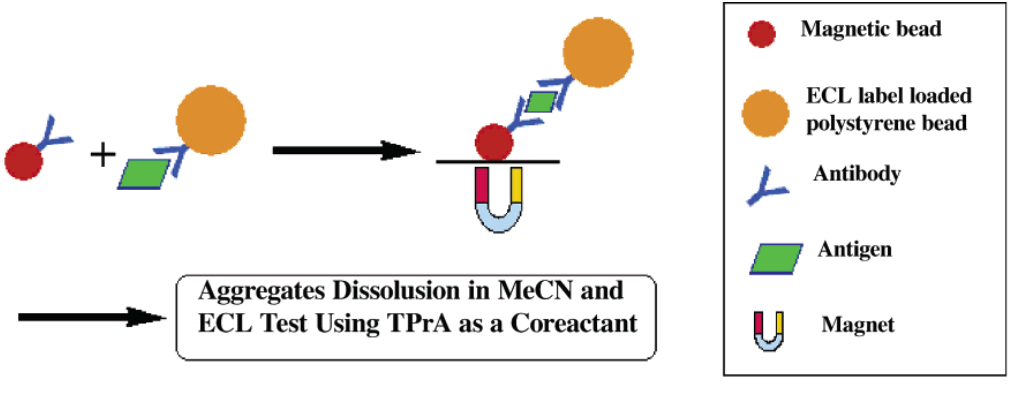
Figure 4. Schematic diagram showing the formation of a sandwich-type aggregate between an antibody-coated MB and an antibody-coated PSB containing entrapped ECL labels in the presence of the antigen species, and the separation of the newly formed aggregate with a magnet as well as the subsequent dissolution and ECL detection in MeCN using TPA as the coreactant. Reprinted from Ref [63] with permission from The American Chemical